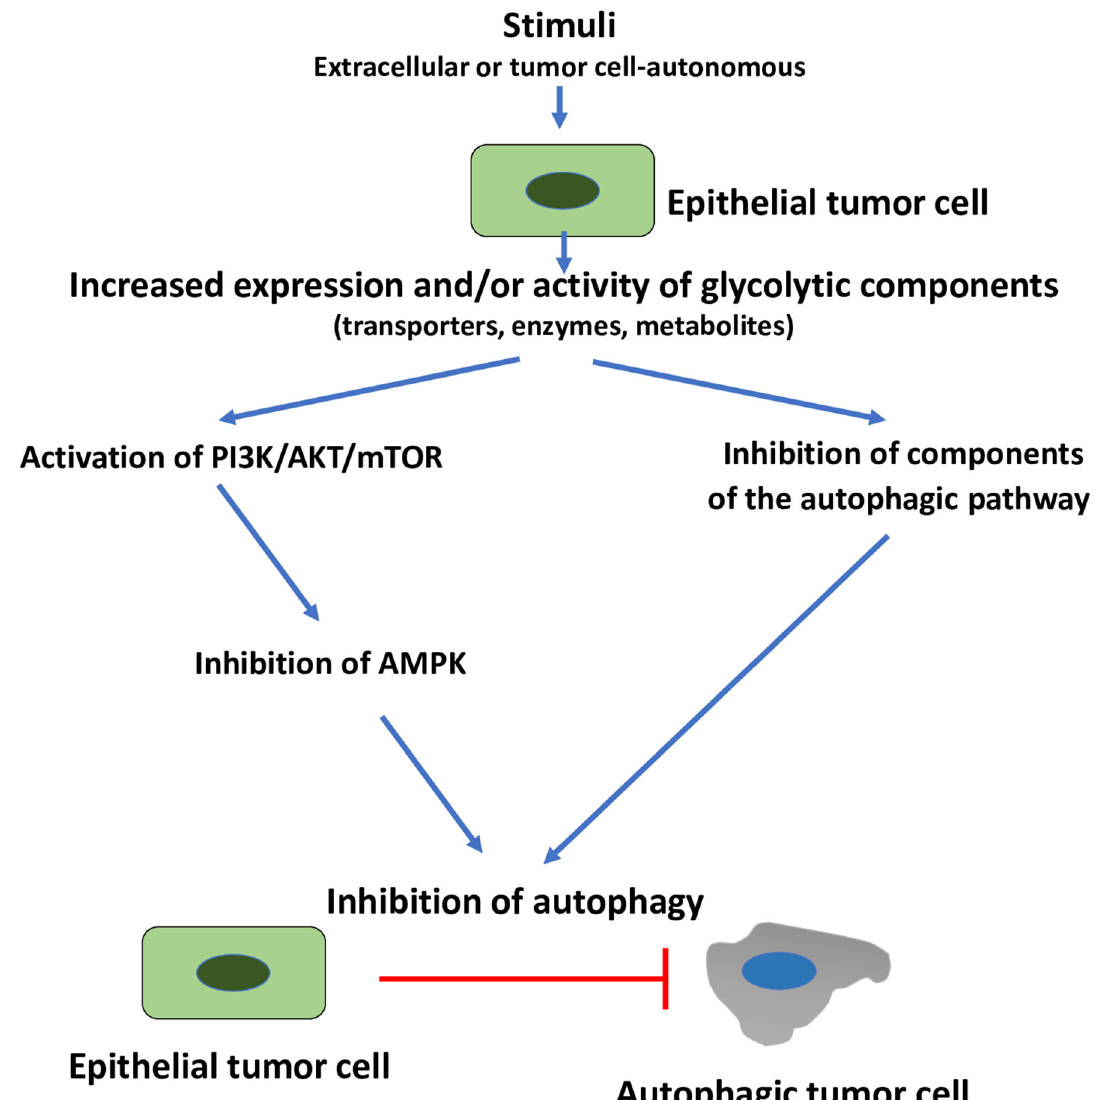
Figure 3. Glycolysis-induced autophagy inhibition. Stimuli, either tumor cell-autonomous or from the TME (extracellular) increase the expression and/or activity of one or more glycolytic components (transporters, enzymes or metabolites). This can lead to activation of several signaling pathways. One of these pathways is the PI3K/AKT/mTOR pathway which leads also to AMPK inhibition and, consequently, to autophagy inhibition. Autophagy inhibition can occur also due to an inhibitory interaction of a glycolytic enzyme with components of the autophagy pathway. AMPK, adenosine monophosphate-activated protein kinase; EMT, epithelial–mesenchymal transition; PI3K/AKT/mTOR, phosphatidylinositol 3-kinase/AKT/mechanistic target of rapamycin.